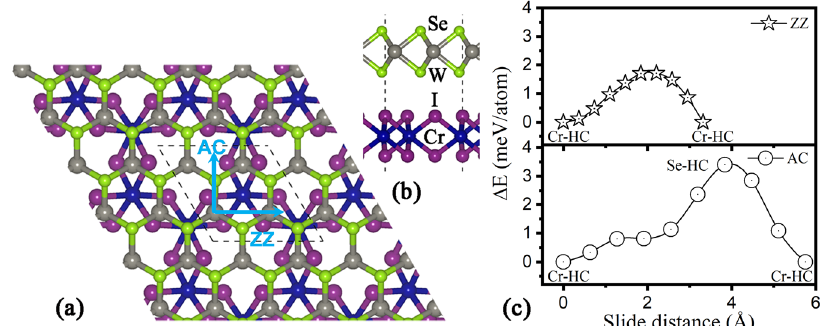
Fig. 1 Structural model and stability of non-twisted WSe 2 /CrI 3 heterostructure. a Top and b side views of 2D WSe 2 /CrI 3 with θ = 0 ˚ . Dashed lines indicate the unit cell. Blue arrows in panel a indicate sliding directions. c Energy as a function of sliding the WSe 2 with respect to CrI 3 , along the ZZ and AC directions, respectively.